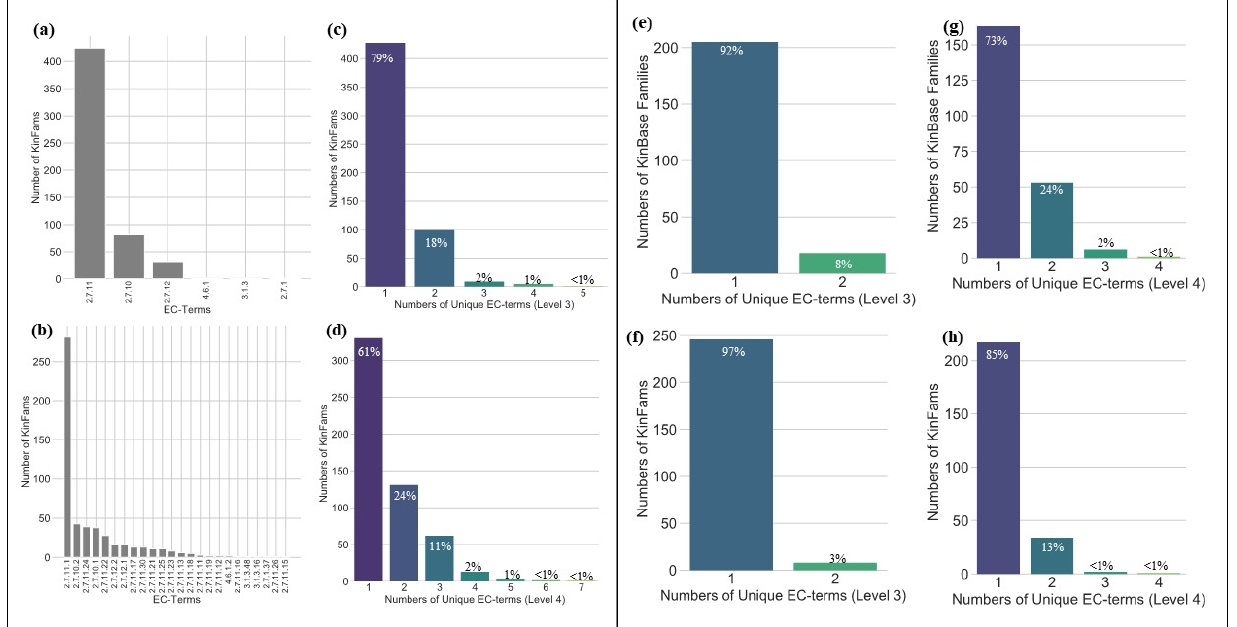
Figure 5. Species distribution associated with KinFams.